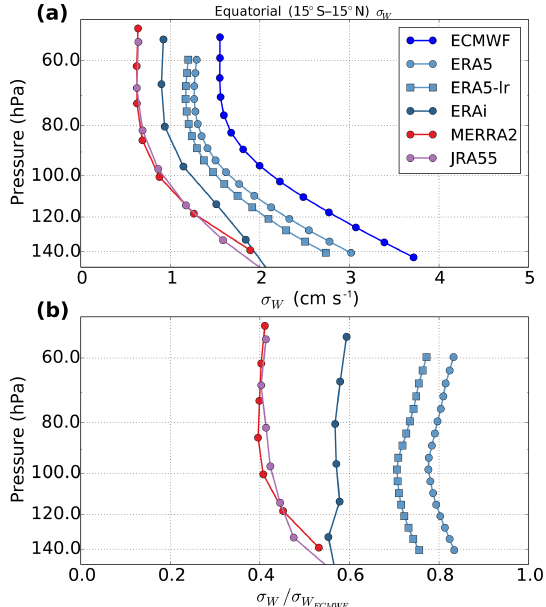
Figure 6. (a) Equatorial (15 ◦ S–15 ◦ N) average profile of verti- cal velocity standard deviation in different reanalysis systems for March 2010. (b) The same but normalized by the profile from the 2010 ECMWF operational analysis. ERA5-lr is a retrieval from ERA5 reanalysis truncated at the same resolution as ERA-Interim (T255). The position of the dots corresponds to the model vertical levels and emphasizes the better resolution of ERA5 in the tropical tropopause layer compared to earlier